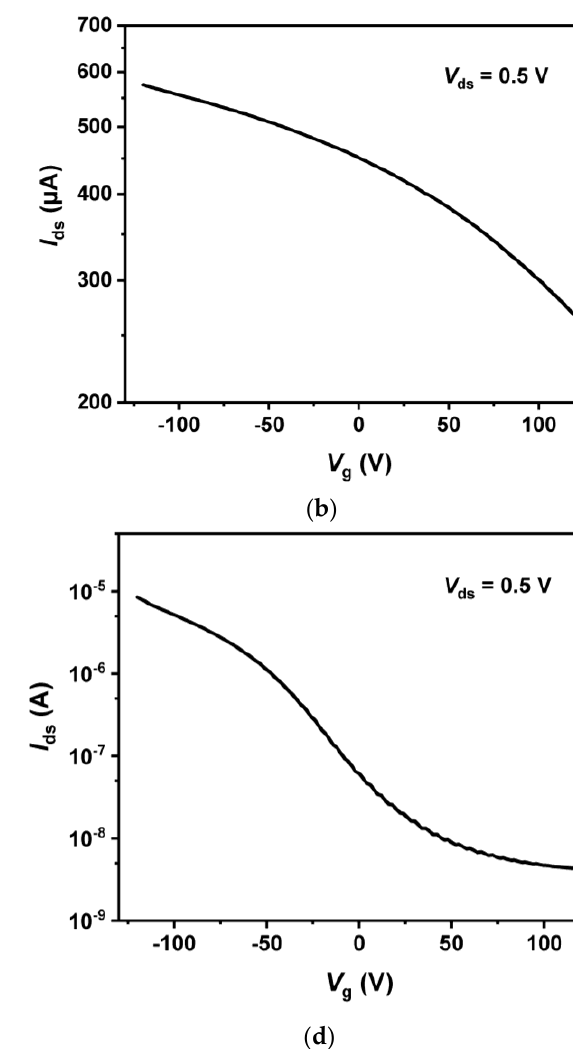
Figure 3. The optical and electrical characterizations of the graphene and MoTe 2 field-effect transistors (FETs): ( a ) the source-drain current-voltage ( I ds — V ds ) curve of a graphene FET. Inset: the optical image of the graphene FET. The scale bar is 100 µm. The I ds — V ds curve shows linear behavior, indicating the ohmic contact between the graphene and the Pd/Au electrodes; ( b ) the transfer curve of the graphene FET, which exhibits p -type behavior; ( c ) the I ds — V ds curve of a MoTe 2 FET. Inset: the optical image of the MoTe 2 FET. The scale bar is 100 µm. The I ds — V ds curve shows linear behavior,